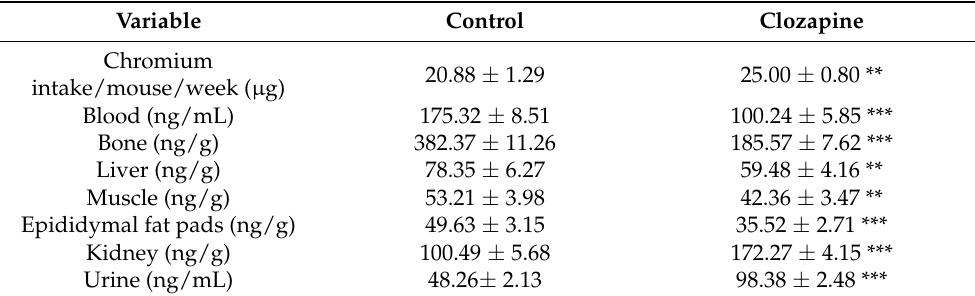
Table 2. Tissue and organ chromium levels in clozapine and control groups after 8-week experimental